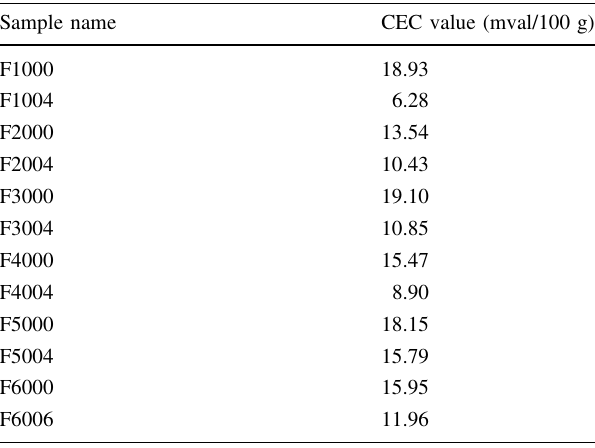
Table 4 CEC values for raw FA samples and derivatives after